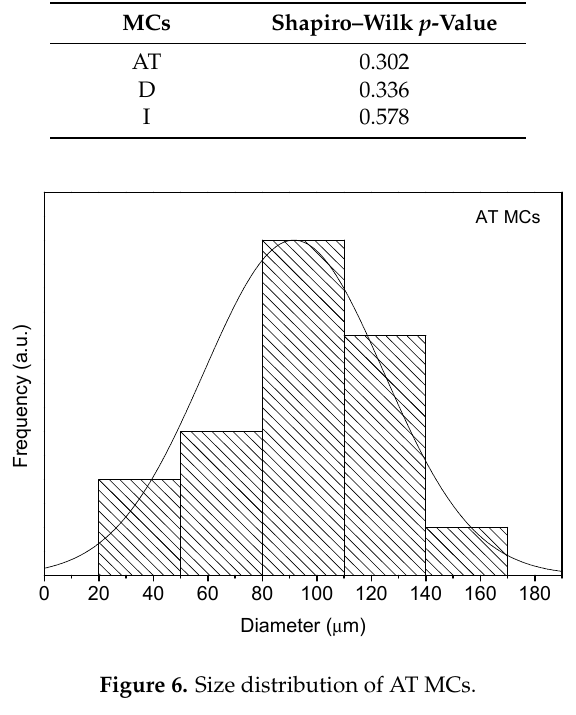
Figure 6. Size distribution of AT MCs.